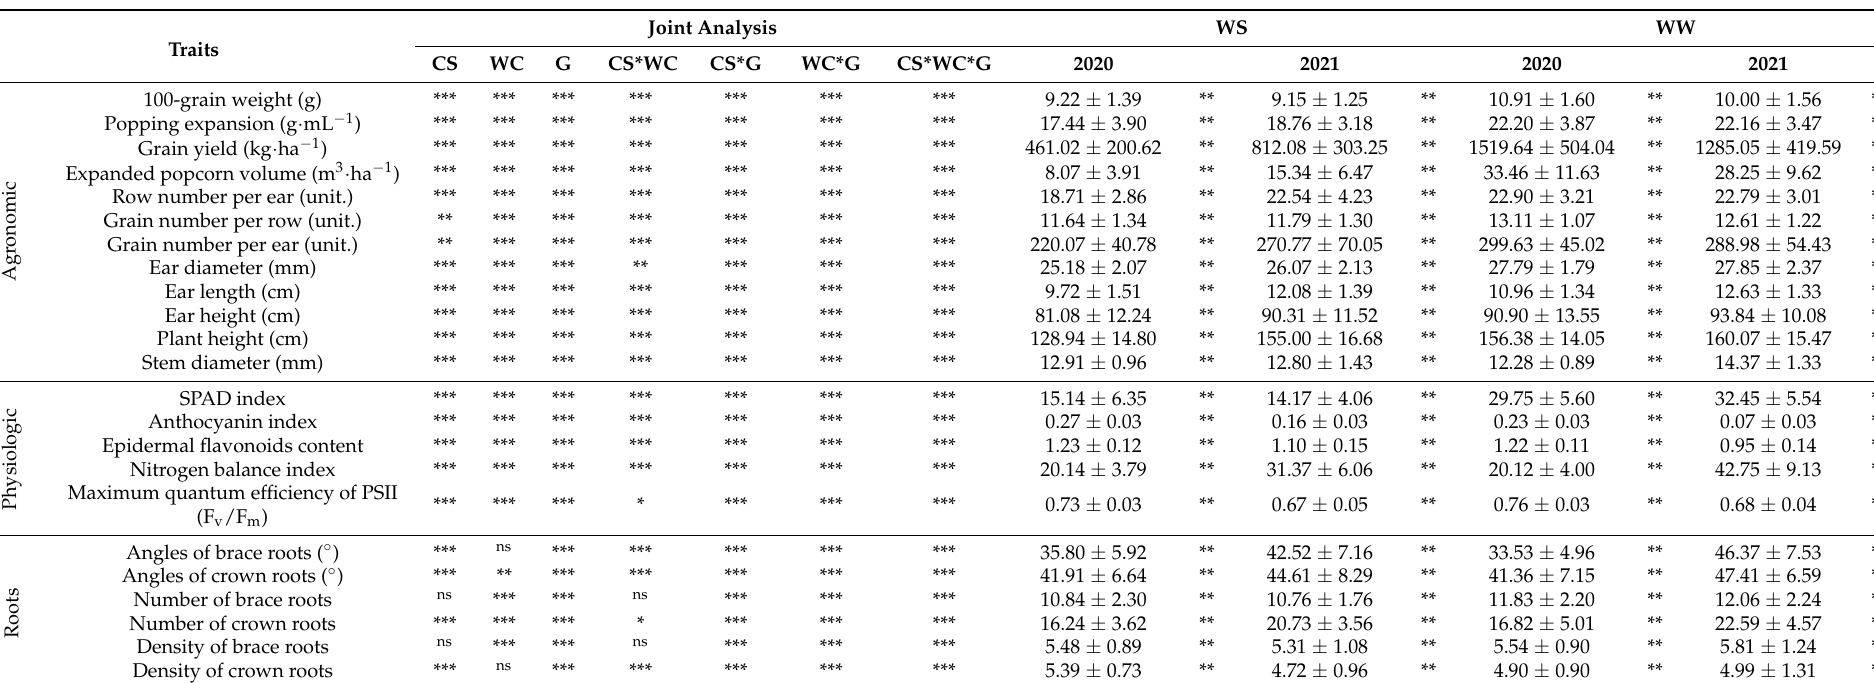
Table 1. Summary of joint and individual analysis of variance, estimates of means, and standard deviations associated with agronomic, physiological, and morphological characteristics of the root system of popcorn lines under different water conditions (WS and WW) and crop seasons (2020 and 2021).